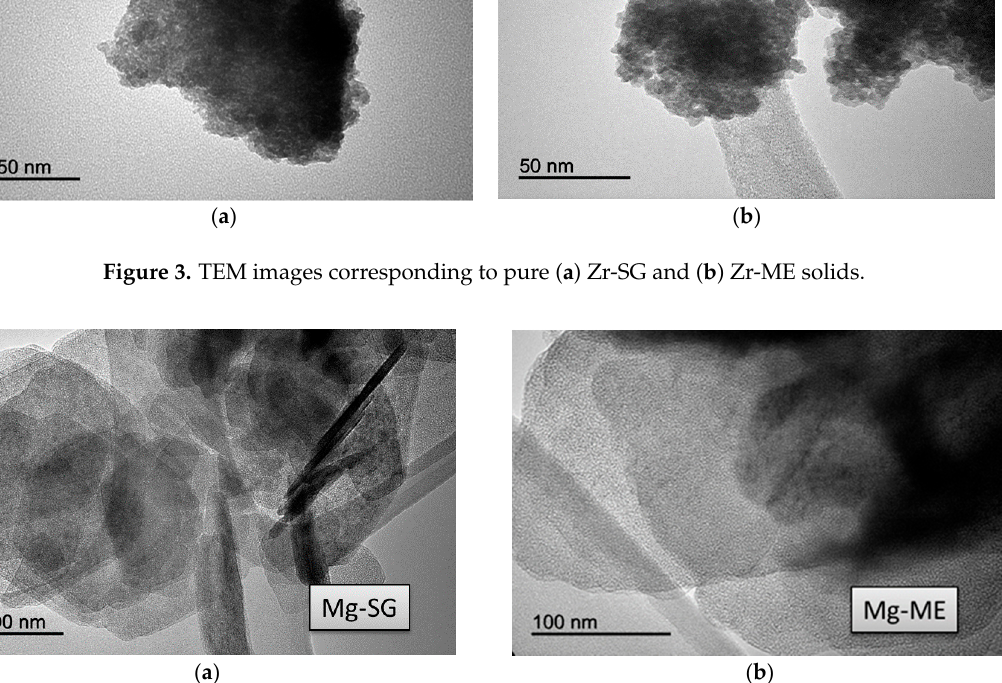
Figure 4 . TEM images corresponding to pure ( a ) Mg-SG and ( b ) Mg-ME solids.